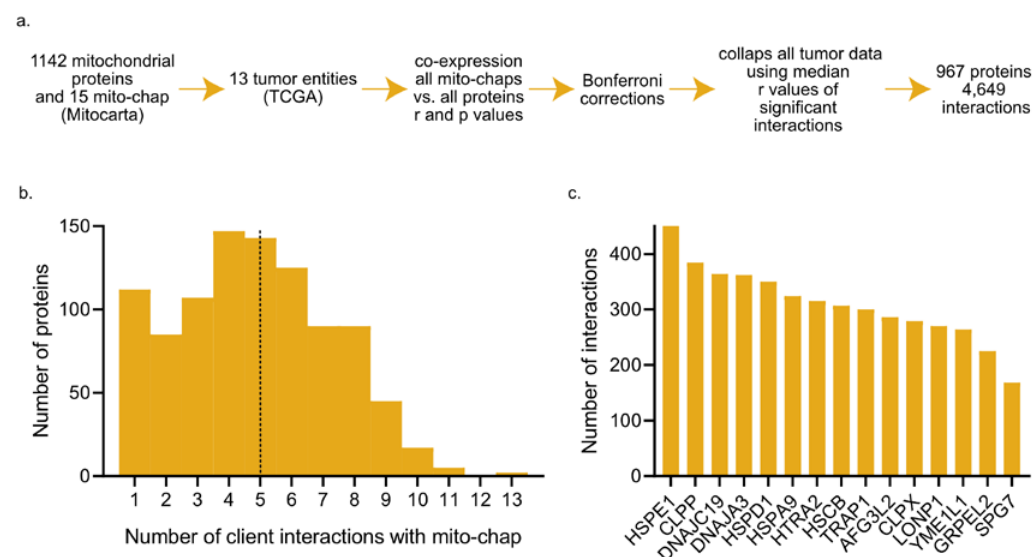
Figure 1. ( a ) Workflow scheme. ( b ) Distribution of the number of interactions with chaperones, dashed line depicts the median number of interactions per protein. ( c ) The number of interactions of each mitochondrial chaperone (mito-chap).